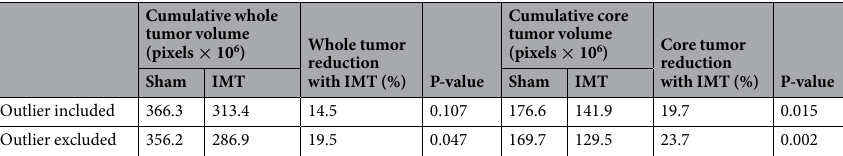
Table 3. Cumulative in vivo tumor burden in sham and IMT-treated GBM within the 15-animal